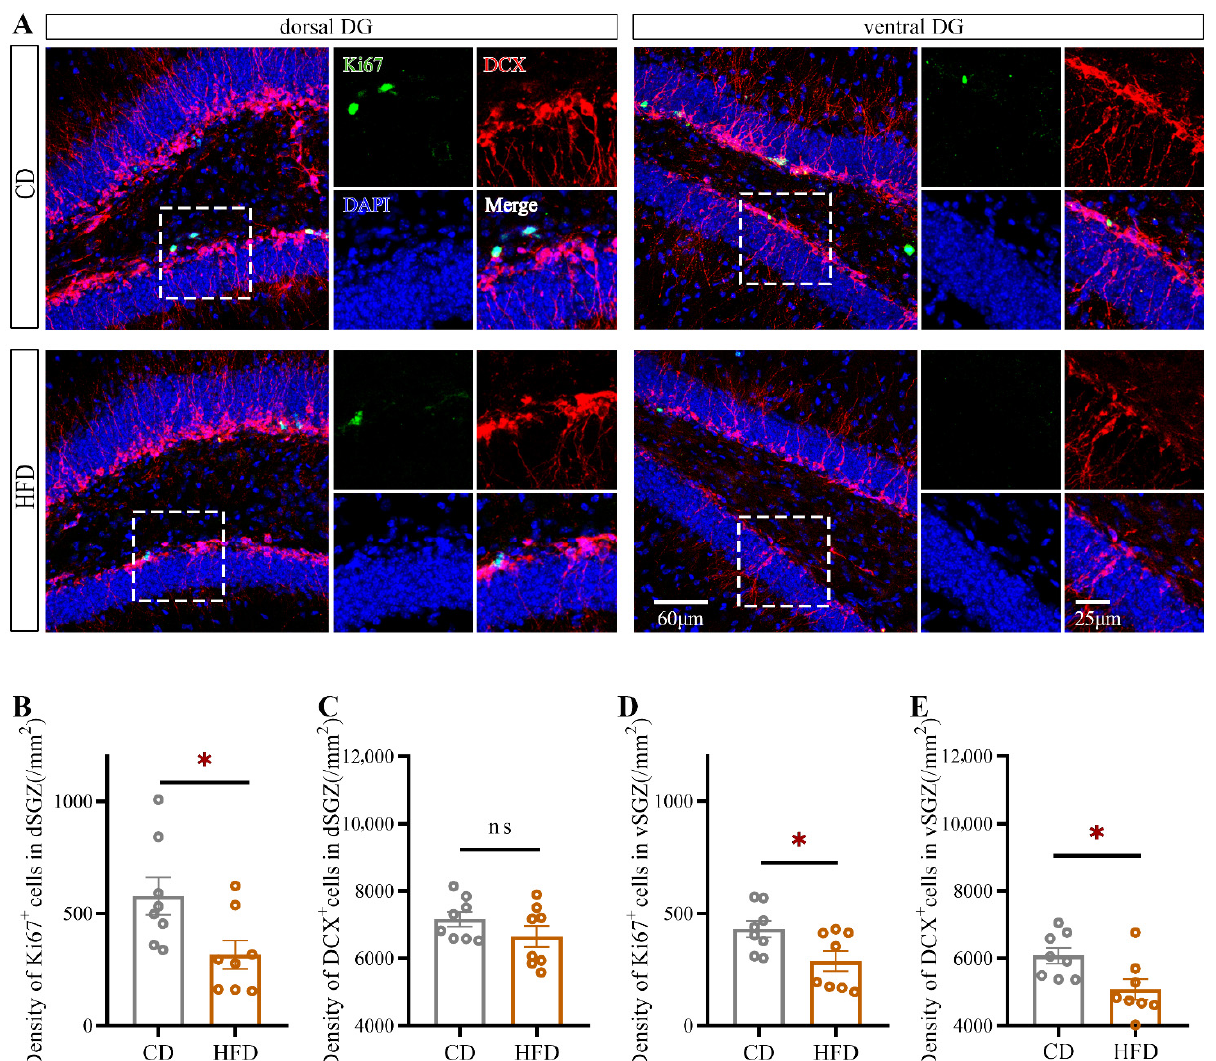
Figure 3. Effect of HFD consumption in adolescence on DCX and Ki67 expression in the mouse hippocampus. ( A ) Fluorescence staining of DCX + and Ki67 + cells in the dorsal and ventral hippocampus of CD- and HFD-fed mice. Green, red and blue fluorescence represent Ki67, DCX, and DAPI, respectively. The numbers of Ki67 + and DCX + cells in the dSGZ ( B , C ) and vSGZ ( D , E ) were counted. The data are expressed as the mean ± SEM ( n = 8 mice per group). When the HFD group was compared with the CD group, the data were analyzed using Student’s t -test. ns, not significant; * p < 0.05.